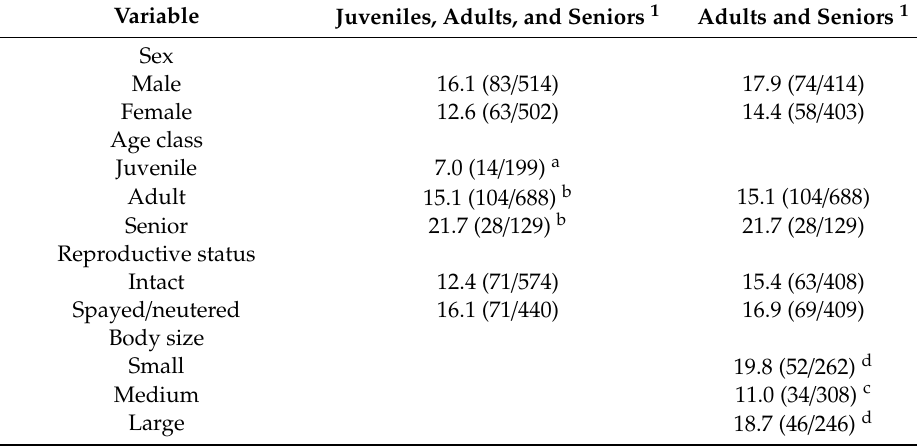
Table 2. The percentages of dogs assessed as resource guarders in relation to sex, age class, reproductive status, and body size. The number of dogs assessed as resource guarders / number of dogs evaluated and made available for adoption shown in parentheses. Within columns and specific variables, values with di ff erent superscript letters are significantly di ff erent ( p ≤